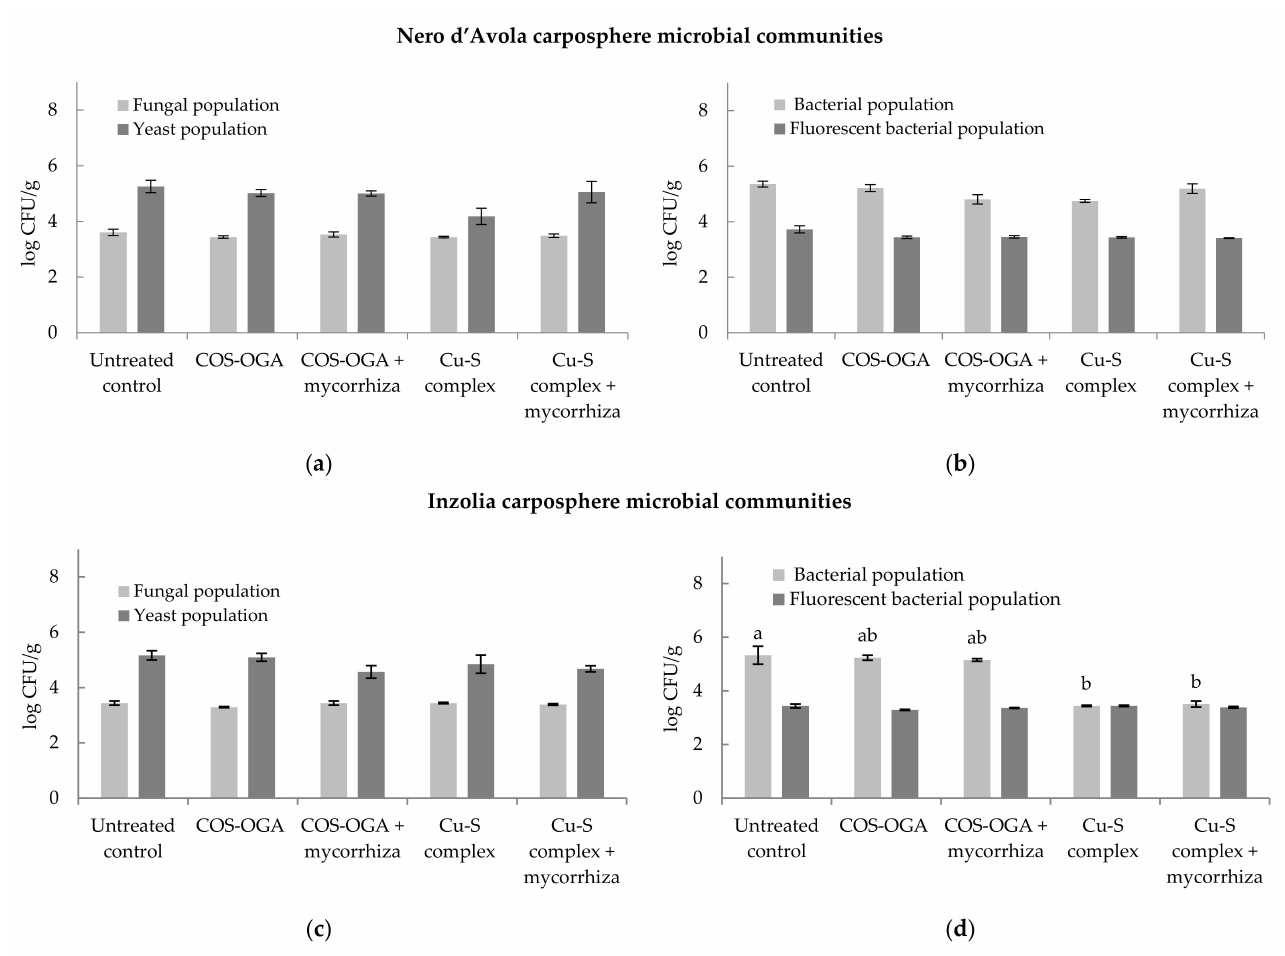
Figure 6. Fungal and yeast population on ( a ) Nero d’Avola and ( c ) Inzolia carposphere. Bacterial and fluorescent bacterial population on ( b ) Nero d’Avola and ( d ) Inzolia carposphere. Data presented as Log 10 CFU/g of fresh weight. Bars show the standard error of the mean ( ± SEM). Bacterial popula- tion data followed by different letter(s) differs significantly according to Fisher’s least significance differences test ( α =